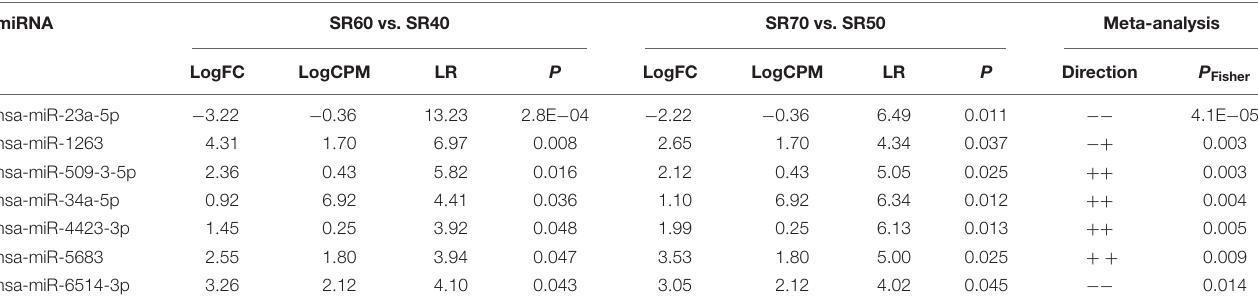
FIGURE 2 | Comparative analysis of seven human AA-associated miRNAs. (A) Correlation analysis of effect size of miRNAs from SR60 vs. SR40, and SR70 vs. SR50. LogFC, fold change (SR60/SR40 or SR70/SR50) at log2 scale. (B) Venn diagram showing two miRNAs overlapping with cardiac aging-related miRNAs [GSE433556, false discovery rate (FDR) < 0.05]. (C,D) Linear regression analysis of miR-23a-5p and miR-34a-5p with age. The miRNA expression was quantified as count per million at log2 scale ( Y -axis). For each miRNA, linear tread and 95% confidence interval were shown as purple line and a gray area. (E) Independent qRT-PCR replication of three miRNAs among four groups. TABLE 1 | miRNA-seq Identified 7 miRNAs Associated with Human AA. SR60 vs. SR40 SR70 vs.